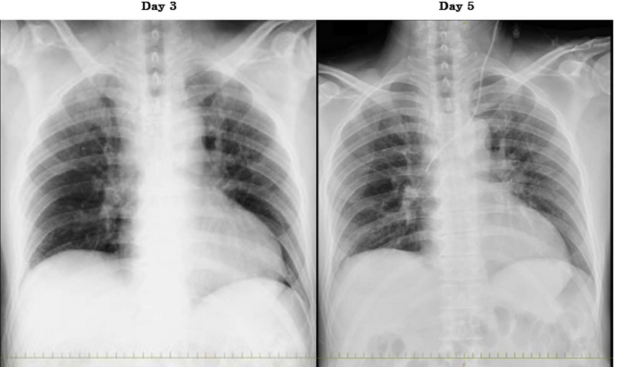
Figure 1. Chest radiograph. Compared to day 3, an air bronchogram appeared at the upper- and middle-lung fields on the left side on day 5.